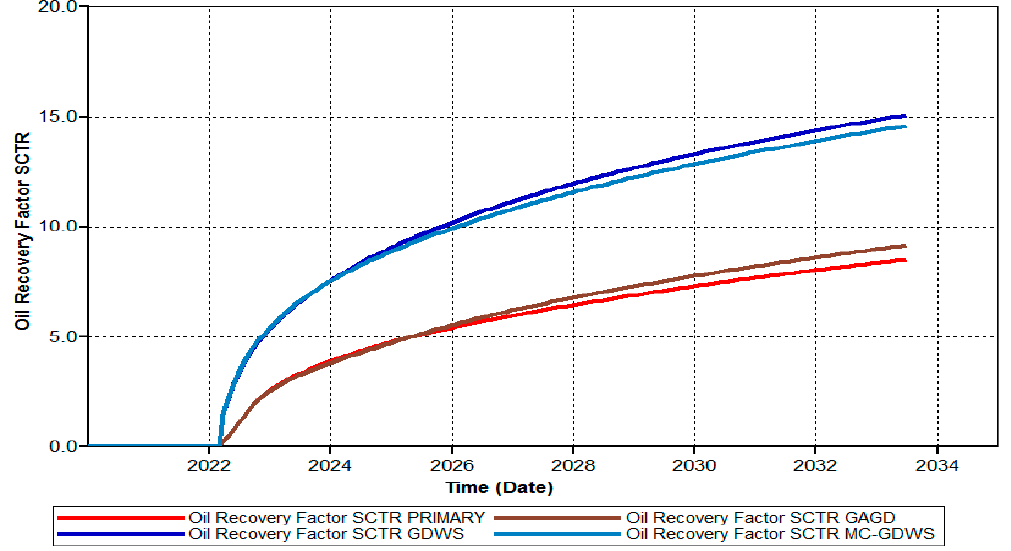
Figure 9. Oil-recovery factor expressed by year for the TC-GDWS-AGD, GDWS-AGD, GAGD, and primary (base-case) PUNQ-S3 simulations.